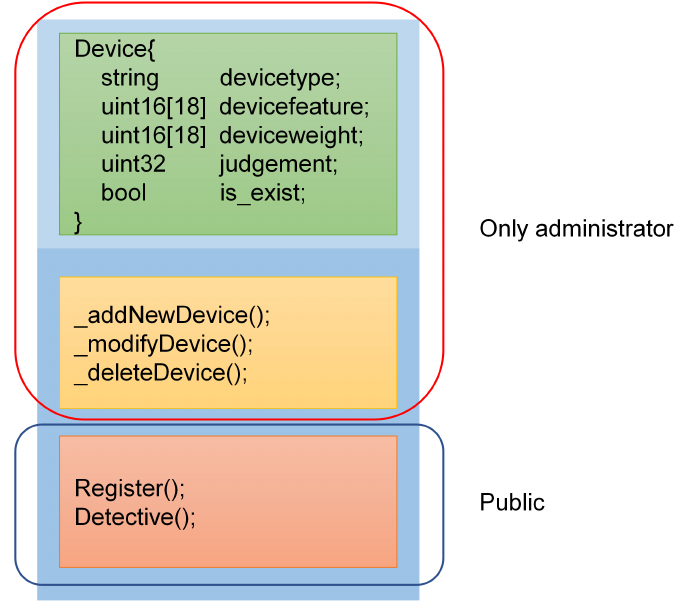
Figure 3. Some details of the smart